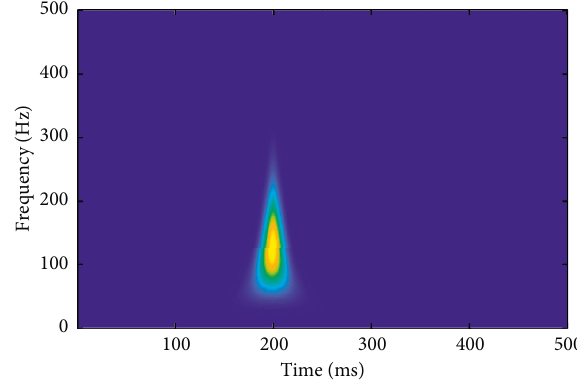
Figure 3: Time-frequency with S transform.